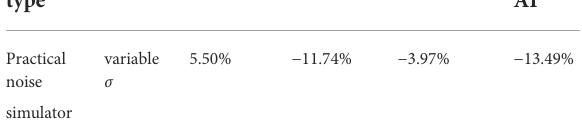
TABLE 4 The PSNR-based BD-rate of the proposed JICD compared to the Cheng model on noisy input reconstruction.